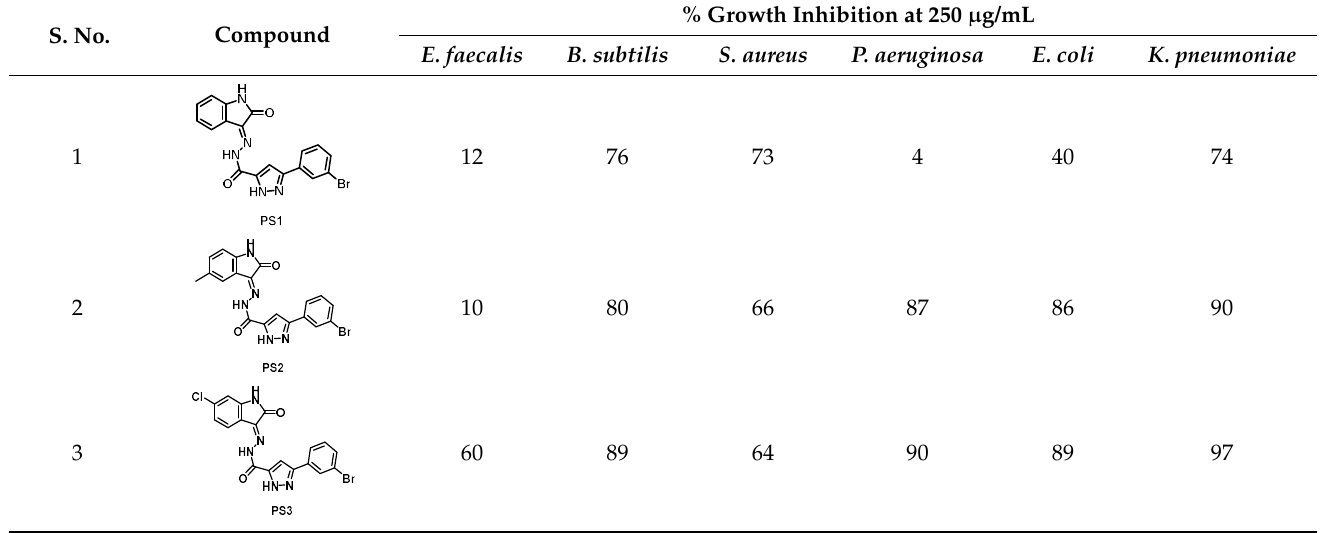
Table 2. Growth inhibition profile of PS series ( µ g/mL).